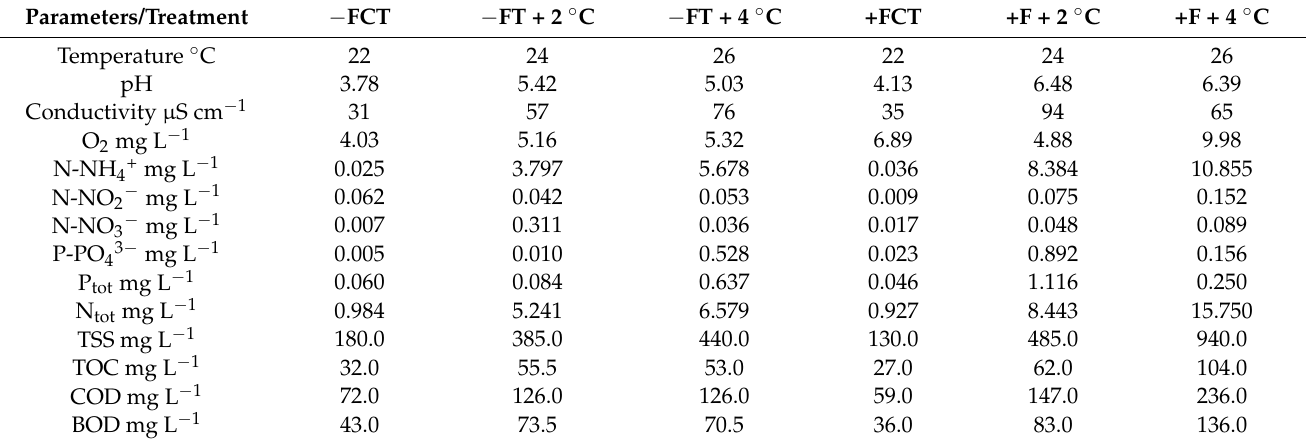
Table 1. Changes in physical and chemical parameters in six experimental mesocosms. Key: reaction (pH), dissolved oxygen (DO), total phosphorus (P tot ), phosphates (P-PO 43 − ), total nitrogen (N tot ), ammonia nitrogen (N-NH 4 ), nitrite nitrogen (N-NO 2 − ), chemical oxygen demand (COD), biological oxygen demand (BOD), total suspended solids (TSS), total organic carbon (TOC), treatments − FCT (control), − FT + 2 ◦ C (treatment without fish with temperature increased by +2 ◦ C relative to the control), and − FT + 4 ◦ C (treatment without fish with temperature increased by +4 ◦ C relative to the control), and treatments with fish: +FCT (control), +FT + 2 ◦ C (treatment with temperature increased by +2 ◦ C relative to the control), and +FT + 4 ◦ C (treatment with temperature increased by +4 ◦